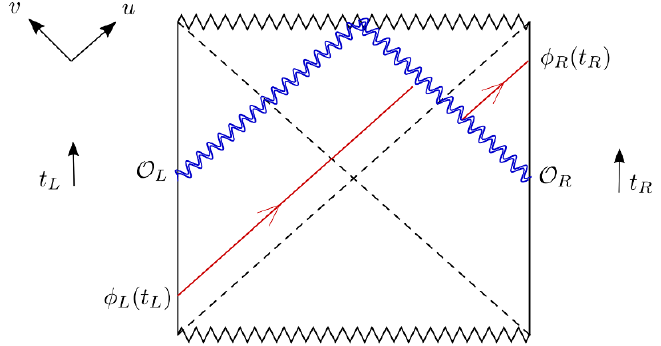
Figure 7 . The setup of the traversable wormhole [6]. The double trace deformation produces negative null energy that causes a time advance in the probe (cid:30)